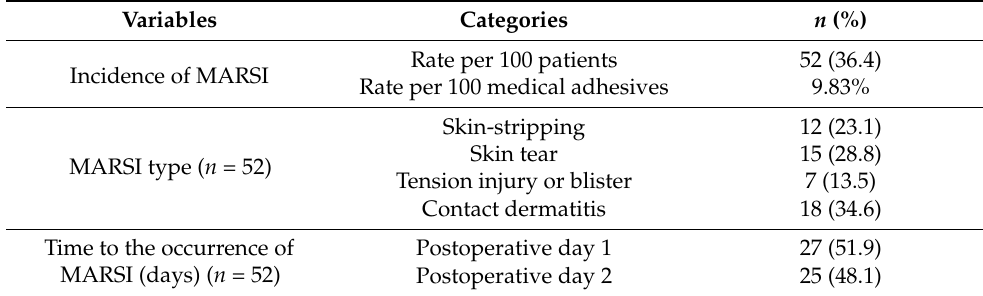
Table 2. Incidence and characteristics of MARSI. ( n = 143).